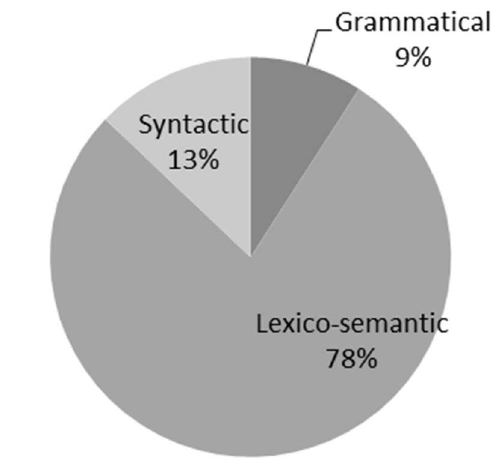
Figure 1. Errors in the English MT output